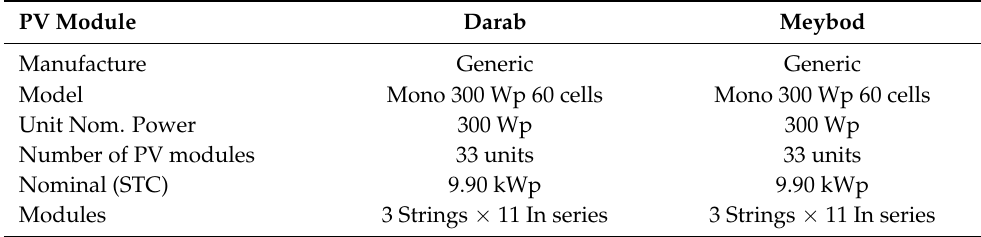
Table 1. Characteristics of PV module and inverters for two investigated areas. PV Module